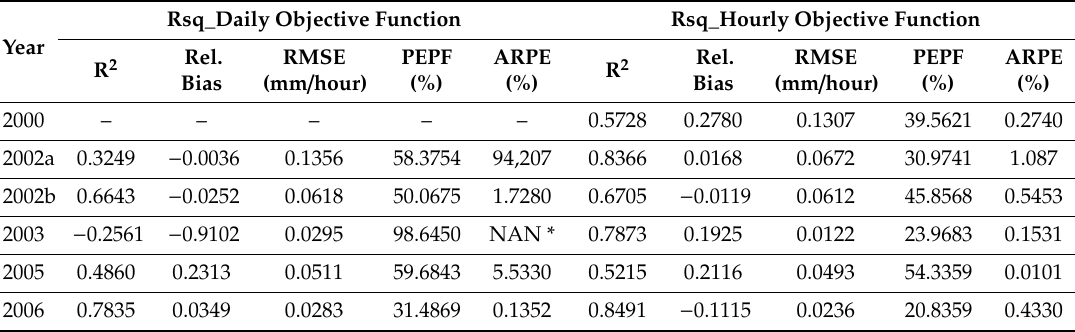
Table 2. IHACRES model performance statistics with objective function constraints.